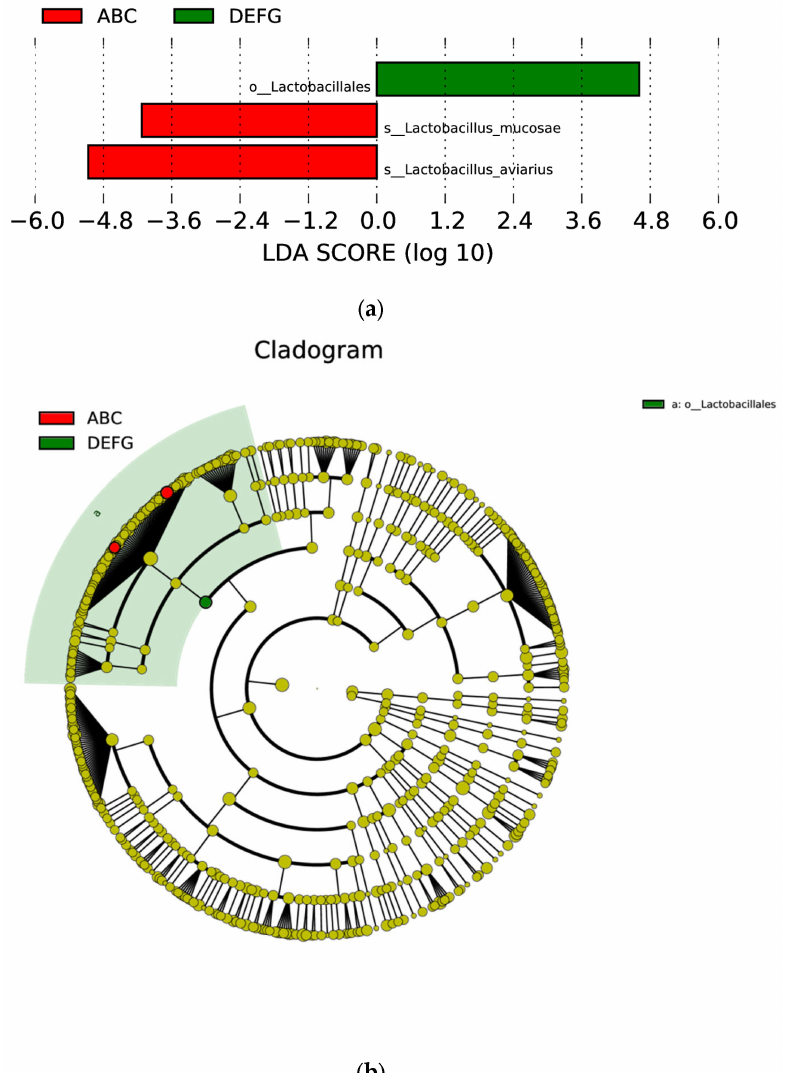
Figure 12. Distribution of LDA values and evolutionary clades of different species. ( a ) is the LDA value distribution of different species. The LDA value distribution histogram shows the species whose LDA score is greater than the set value (the default setting is 4), that is, the biomarker with a significant difference between groups, and the length of the histogram represents the impact size of different species (i.e., LDA score). ( b ) shows the evolutionary clades of different species. The circles radiating from the inside to the outside represent the taxonomic level from phylum to genus (or species). Each small circle at a different taxonomic level represents a taxonomy at that level, and the diameter of the small circle is proportional to the relative abundance. Colouring principle: Species with no significant difference are uniformly coloured yellow, and the biomarkers of different species are coloured according to the group. The red nodes represent the microbial groups that play an important role in the red group, and the green nodes represent the microbial groups that play an important role in the green group. The microorganism species names represented by the English letters in the figure are shown in the legend on the